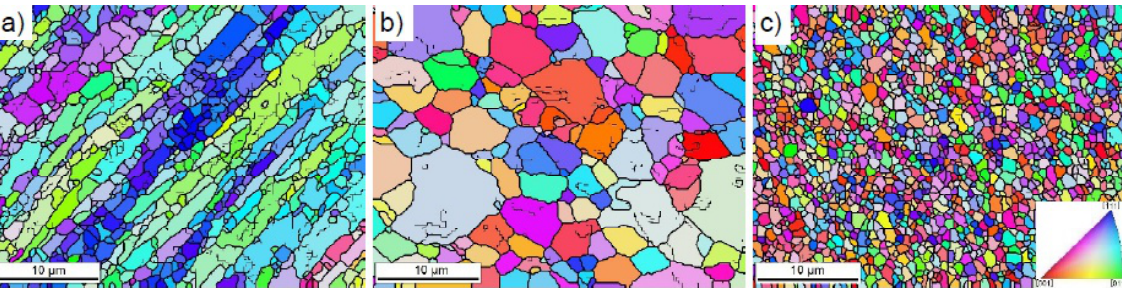
Fig. 3. EBSD maps of Al–0.4Zr(wt.%) alloy in C–R state (a), after AG treatment (b), and after AG–HPT treatment